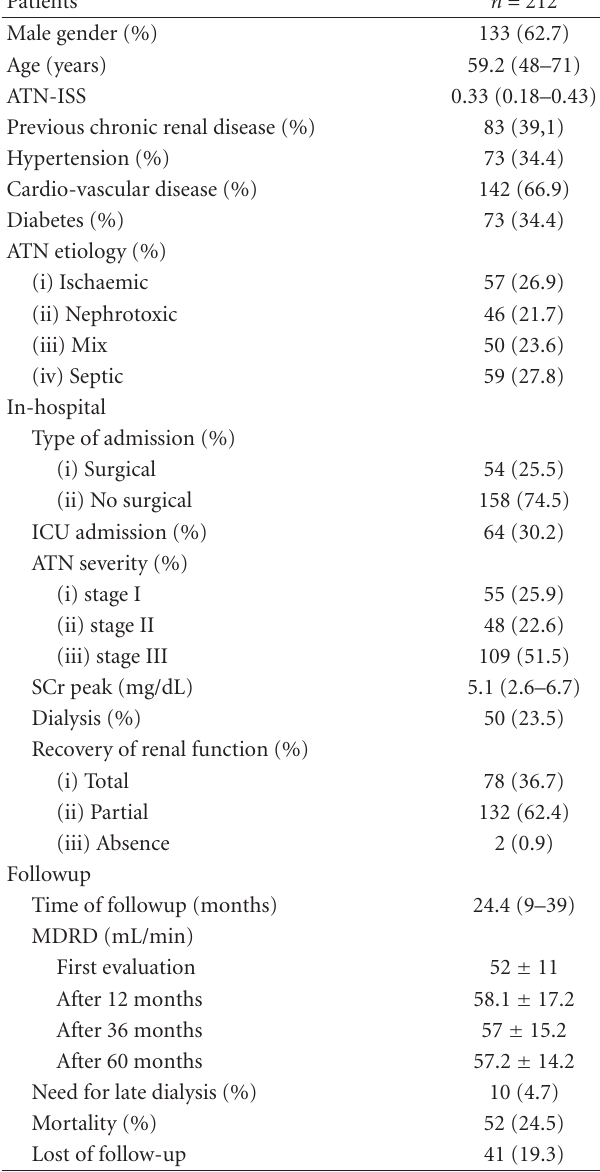
Table 1: Characteristics of the survivor patients after acute tubular necrosis